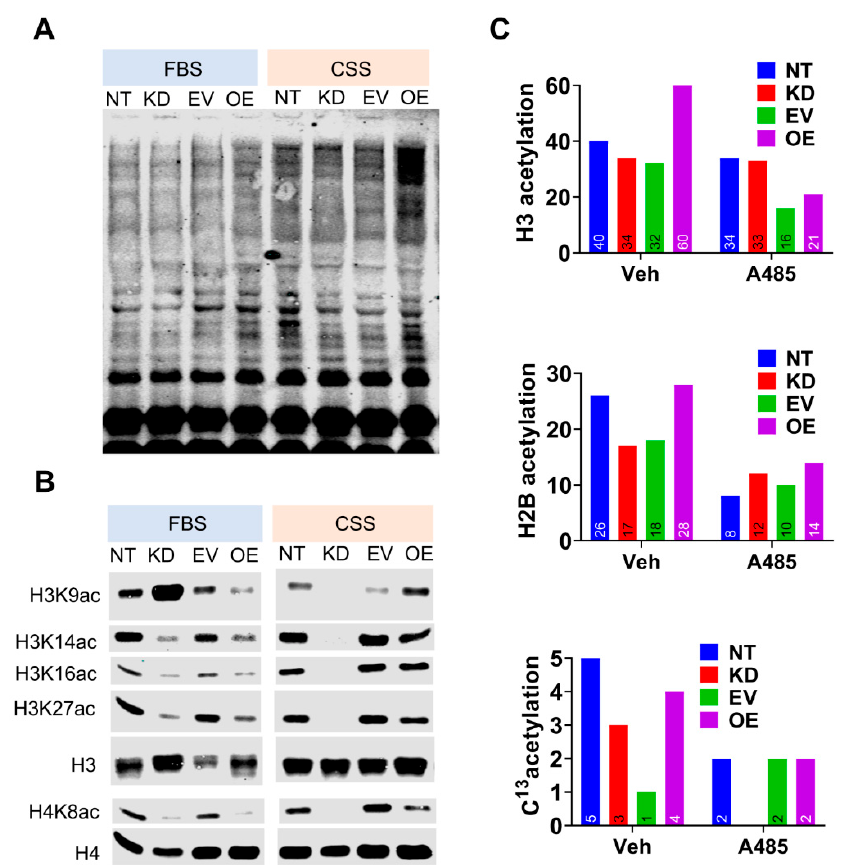
Figure 6. CPT1A expression modulates histone acetylation in an androgen-dependent manner. ( A ): Representative western blot of cell lysates with pan-acetylated lysine antibody. ( B ): Western blot analysis of acetylated histone lysine residues from C4-2 cells (KD and OE) cultured in FBS or CSS (steroid- free media). ( C ): Lysine acetylation of histones H3 and H2B, isolated from C4-2 cells cultured in CSS, with or without p300 inhibitor A485 (5 µM), and measured by mass spectrometric analysis. Additionally, cells were treated with C 13 -acetate for 24 h in CSS with or without A485, followed by histone isolation and mass spectrometric analysis. Numbers on bars indicate amount of specific 13C-acetylated histone peptides identified.